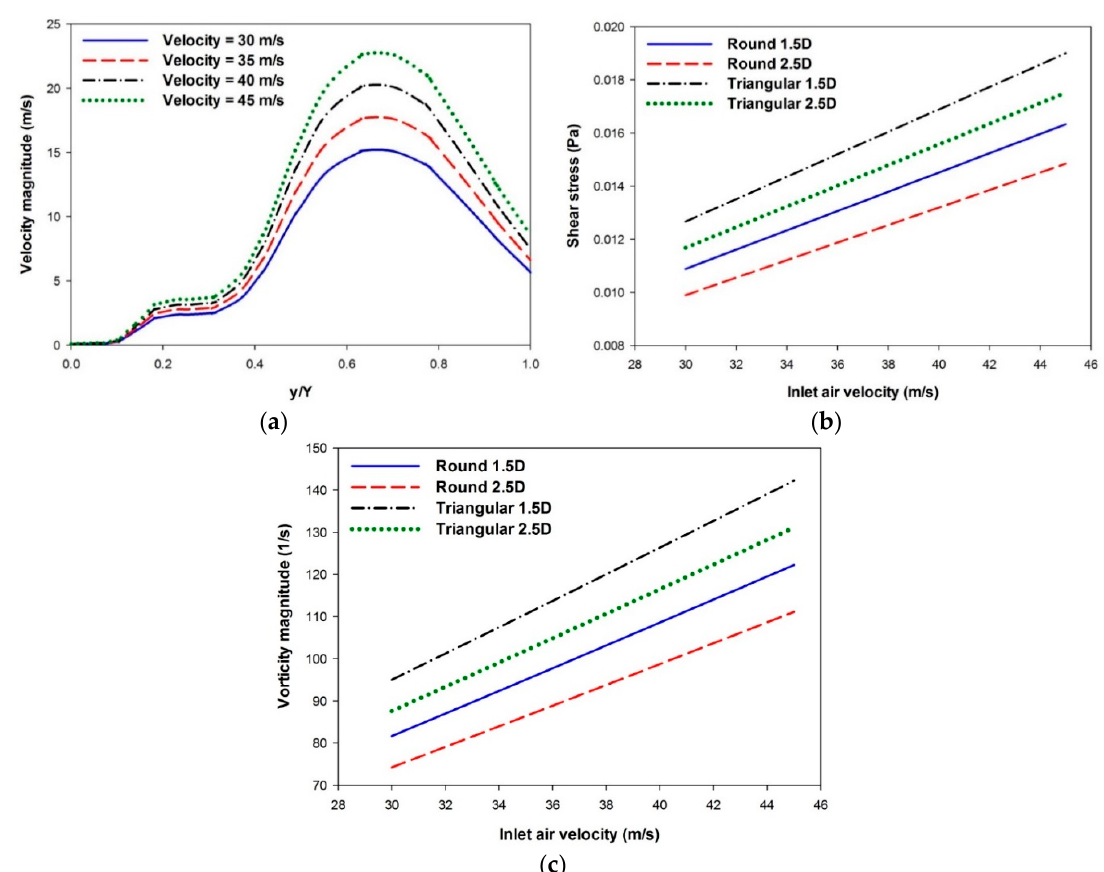
Figure 9. Effect of air inlet velocity on the ( a ) velocity magnitude of +4 D duct hole diameter at point 1, ( b ) shear stress with different duct hole shapes and ( c ) vorticity magnitude with different duct hole shapes at a bed slanting angle ( θ ) of 0°.